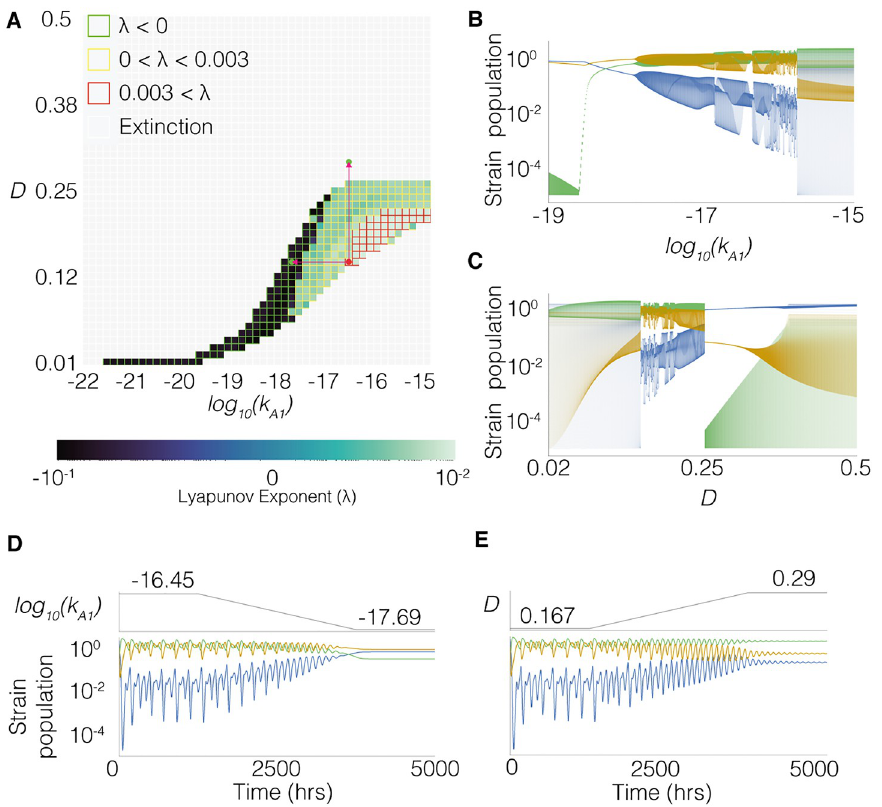
Fig 5. Parameters k A 1 and D can be tuned to control transitions between chaotic, oscillatory and stable states. The fixed parameter values are shown in Table 2. A Map showing how different combinations of k population behaviour. The grid fill colour corresponds to the maximum Lyapunov exponent measured, the grid outlines indicate the approximate classification where green is stable, yellow is oscillatory, red is chaotic and white is extinction. B Bifurcation diagram showing the community states visited for different values of k A 1 . C Bifurcation diagram showing the community states visited for different values of D . D Real-time ramp down tuning of k A 1 , moving the system from a chaotic state to a stable steady state. E Real-time ramp up tuning of D , moving the system from a chaotic state to a stable steady state.